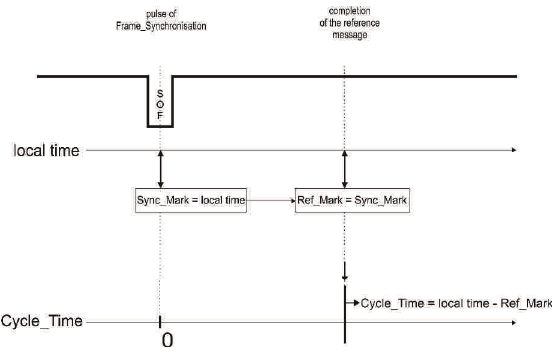
Fig. 2. TTCAN basic cycle synchronisation Level 1